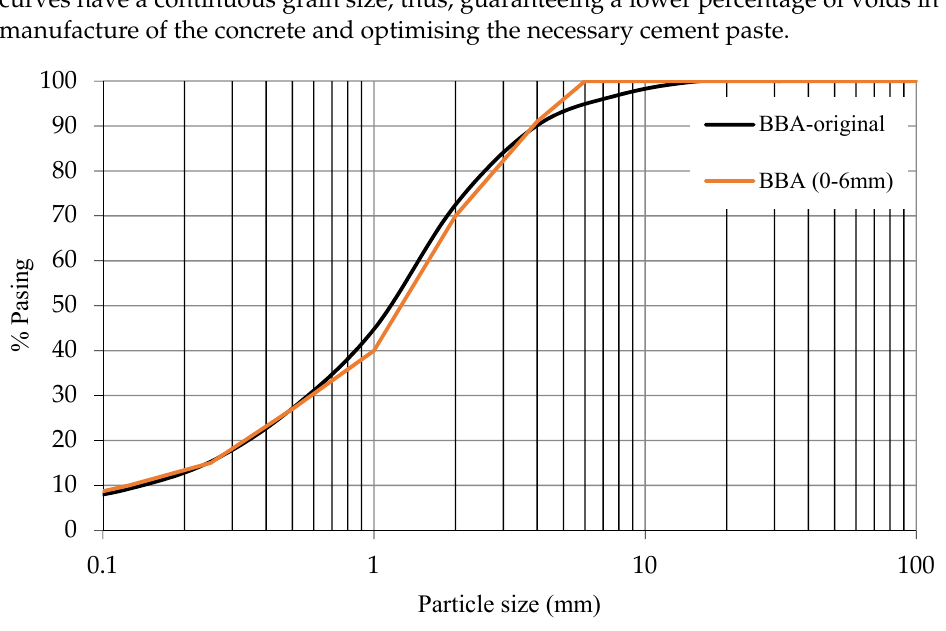
Figure 3. Particle size distribution curve of BBA-Crushed. 3. Dosage The most important condition that must be considered in order to carry out the dos- ing of a self-compacting concrete is to provide a sufficient quantity of the set consisting of “cement + water + fines of less than 0.125 mm content in the aggregates” to achieve self- compacting characteristics. Two series of dosages were carried out. The first series replaced filler with crushed biomass bottom ash (BBA-C) with a replacement of 20%, 40% and 60%, respectively, and the second series replaced natural sand with BBA (10%, 20% and 30%, respectively) with- out any processing. The additive used was MasterGlenium ACE 325 manufactured by BASF. Dosages are shown in Table 3. Table 3. Concrete mix proportions (kg/m 3 ).